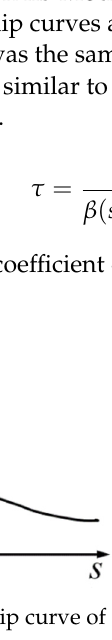
Figure 14. Bond stress-slip curve of Model 4. The shape coefficient β can be obtained by the fitness of test curves. As presented in Figure 15, the values of shape coefficient β decreases with the ratio τ u / s u , and has the ex- ponential relationship of a regression formula.